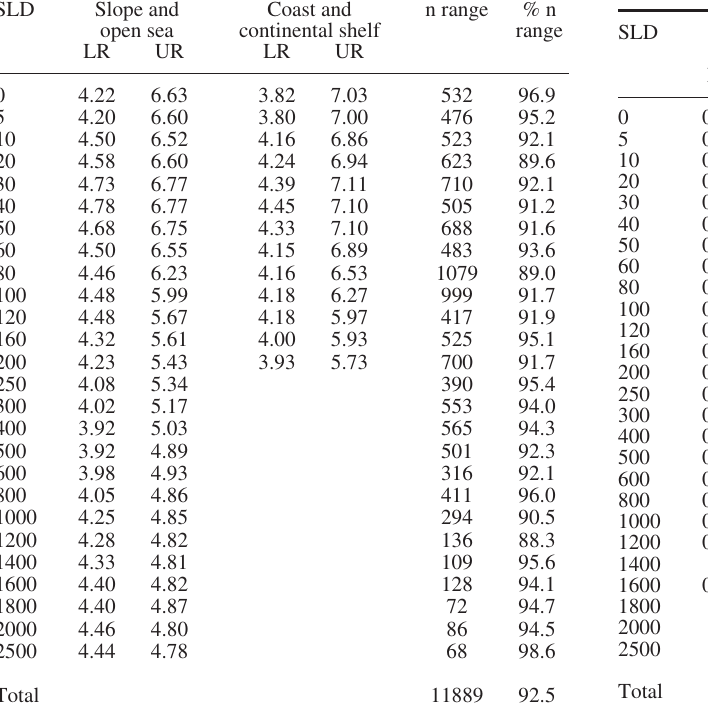
Table 17. – Chl a concentration ( m g l -1 ) ranges in the NW Mediter- ranean Sea in stratified water columns (stratification coefficient = 2, 3 and 4). Headers as in Table